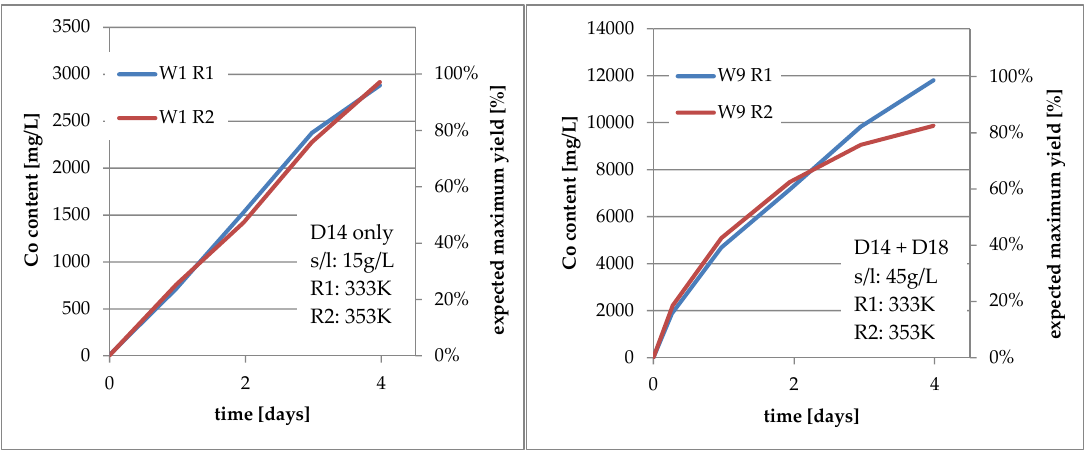
Figure 7. Cobalt concentration versus time in weeks 1 and 9.